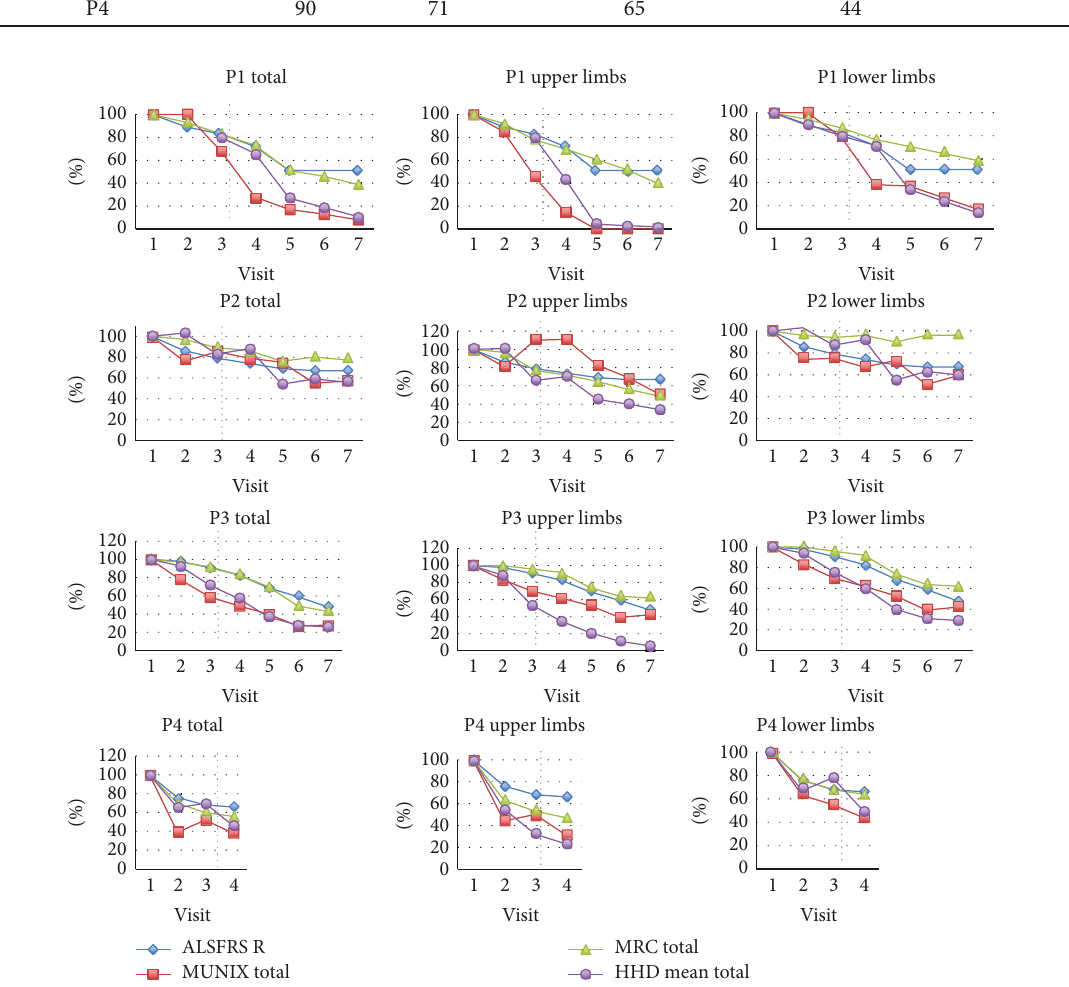
Figure 5: Muscle strength and electrophysiological assessment. The detailed clinical evaluation performed within one week of the neurosurgery procedure and repeated every 3 months throughout the project was complemented with ALS-FRS-R, MRC, MUNIX, and HHD evaluation. ALSFRS R and MRC shared a similar deterioration pattern. The slope of decline was much steeper in the case of both MUNIX and muscle strength as examined by HHD. The MUNIX and HHD showed a marked decline even when the values of ALSFRS R and MRC were still stable ( P1, P2, and P3 — resp. patient 1, patient 2, and patient